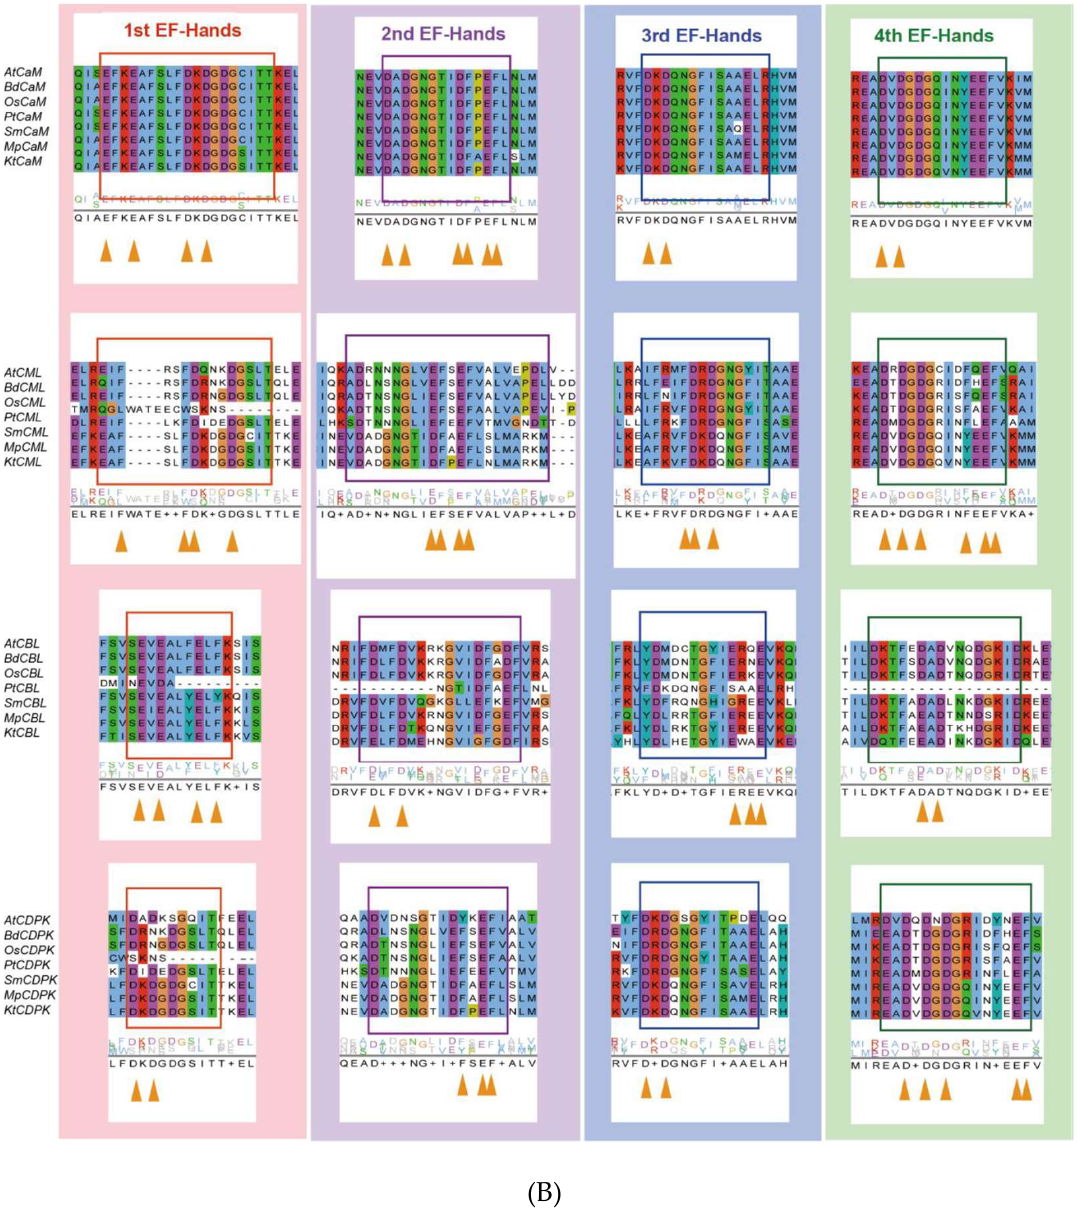
Figure 3. Evolutionary analysis of representative Ca 2+ signalling proteins in the major lineages of green plants. ( A ) Phylogenetic analysis of CML18 protein in representative species of the major lineage of green plants using the OneKP and NCBI databases. The tree is constructed based on the maximum-likelihood method. Clades are indicated by different colors. Two distinctive evolutionary clades are distinguished by the purple and blue branches, respectively. ( B ) Sequence alignment of the CaM, CML, CBL, and CDPK domains among eight representative green plant species. Colored rectangles indicated 1st (red), 2nd (purple), 3rd (blue), and 4th (green) EF-hands motifs. Triangle arrows mark conserved sites. At , Arabidopsis thaliana ; Bd , Brachypodium distachyon ; Os , Oryza sativa ; Pt , Pinus taeda ; Af , Azolla filiculoides ; Sm , Selaginella moellendorffii ; Mp , Marchantia polymorpha ; Kf , Klebsormidium flaccidum .